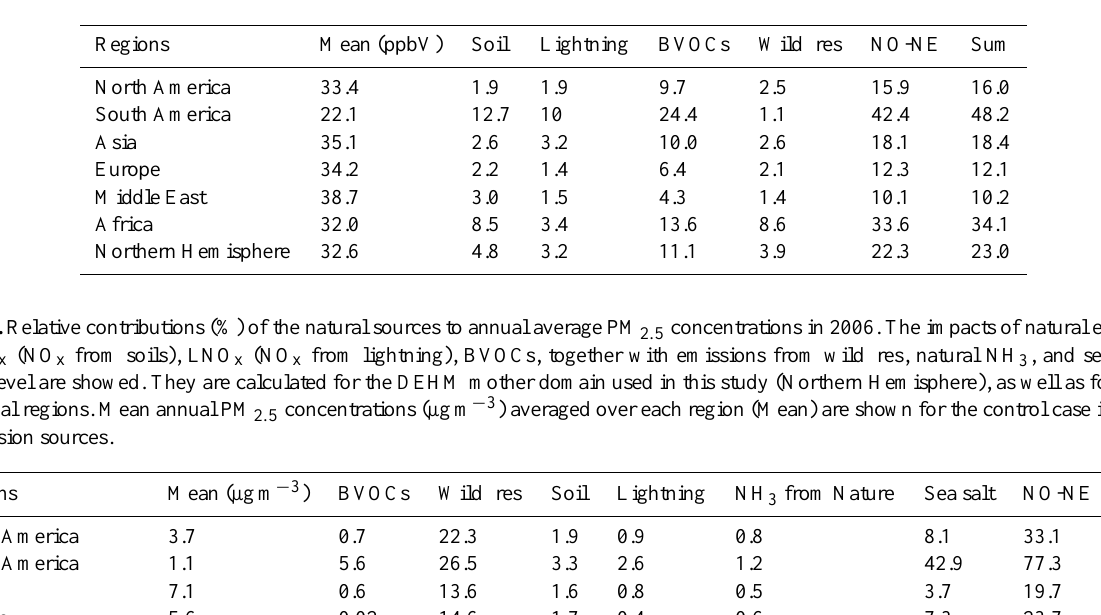
Table 4. Relative contributions (%) of the natural sources with emissions of (a) SNO x (NO x from soils), (b) LNO x (NO x from lightning), (c) BVOCs, and (d) wildfire emissions to annual average ozone mixing ratios in 2006. They are calculated for the DEHM mother domain used in this study (Northern Hemisphere), together with six regions. Mean annual ozone mixing ratios (ppbV) averaged over each region (Mean) are shown for the control case with including all emission sources.